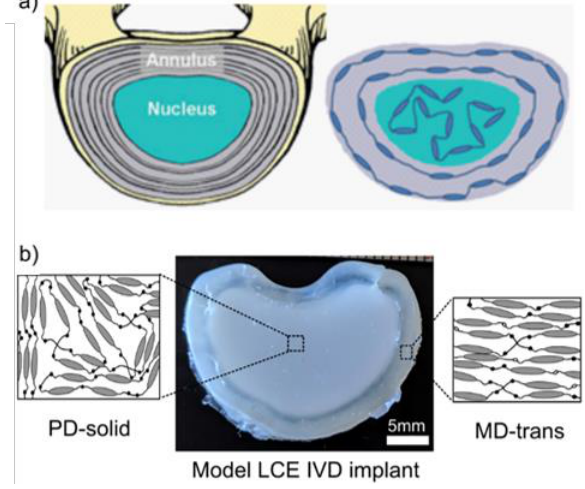
Figure 10. ( a ) A schematic diagram that shows the model intervertebral disc (IVD) was devised by mimicking the collagen alignment with the LCE’s mesogen alignment. ( b ) The model IVD implant made from LCE materials. Solid polydomain LCE was selected as an analogue for the nucleus pulposus, while transversely aligned monodomain material was selected as an analogue for the annulus fibrosus. The outer transversely aligned monodomain surrounded the central polydomain region. Reproduced with permission from Elsevier from Shaha et al.